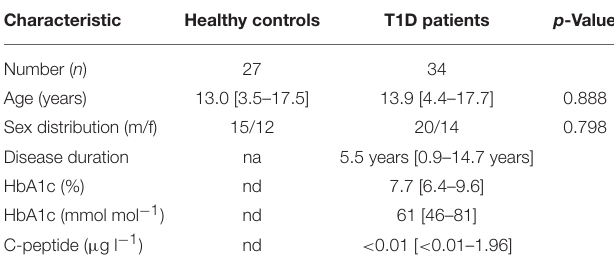
TABLE 1 | Baseline characteristics of children with T1D and healthy